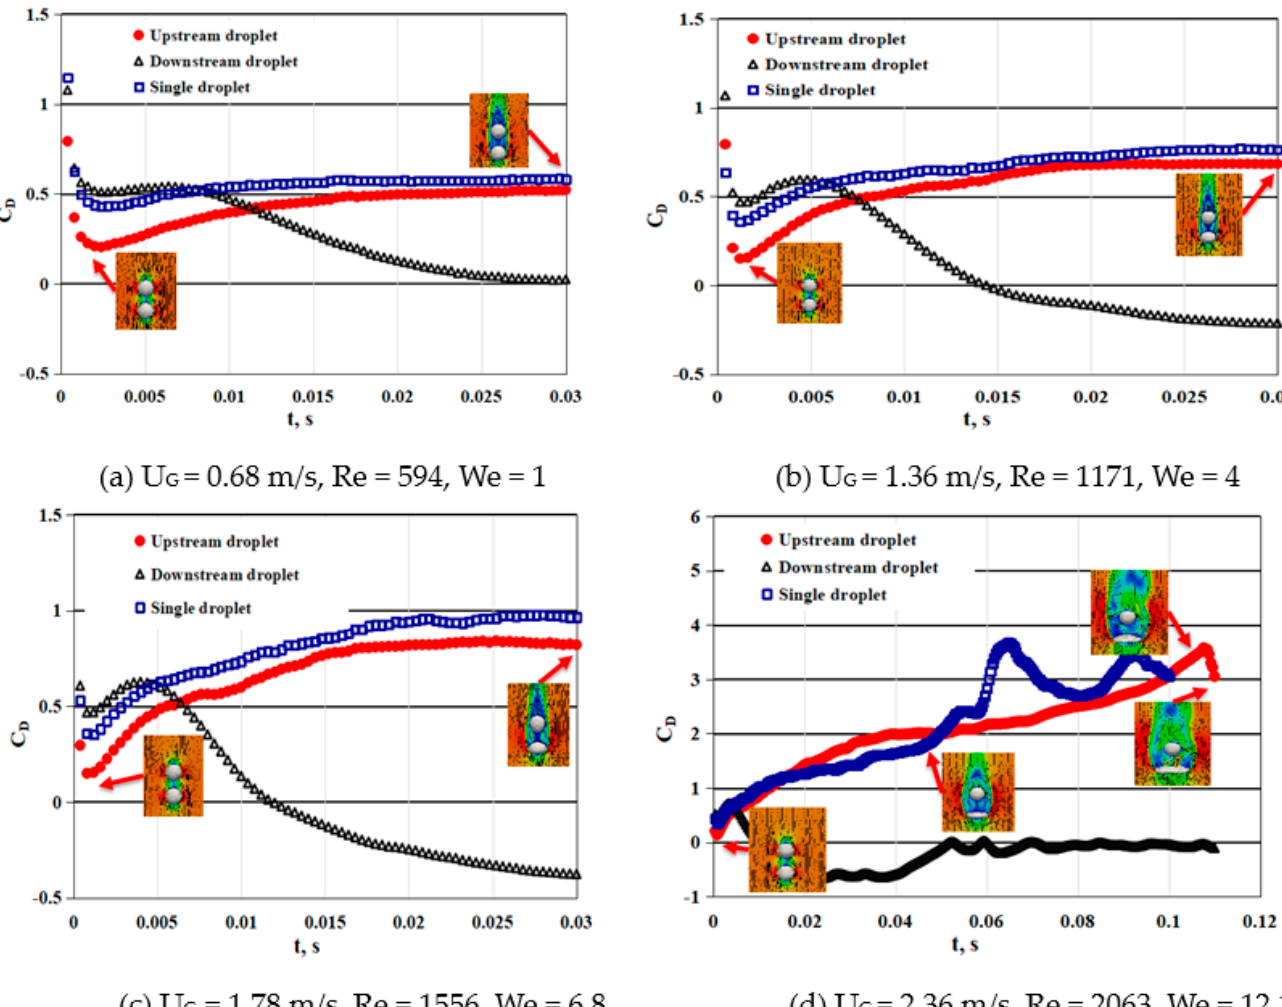
Figure 6. The drag coefficient of two droplets in tandem with different Weber numbers and a separating space between them of 1.5D.